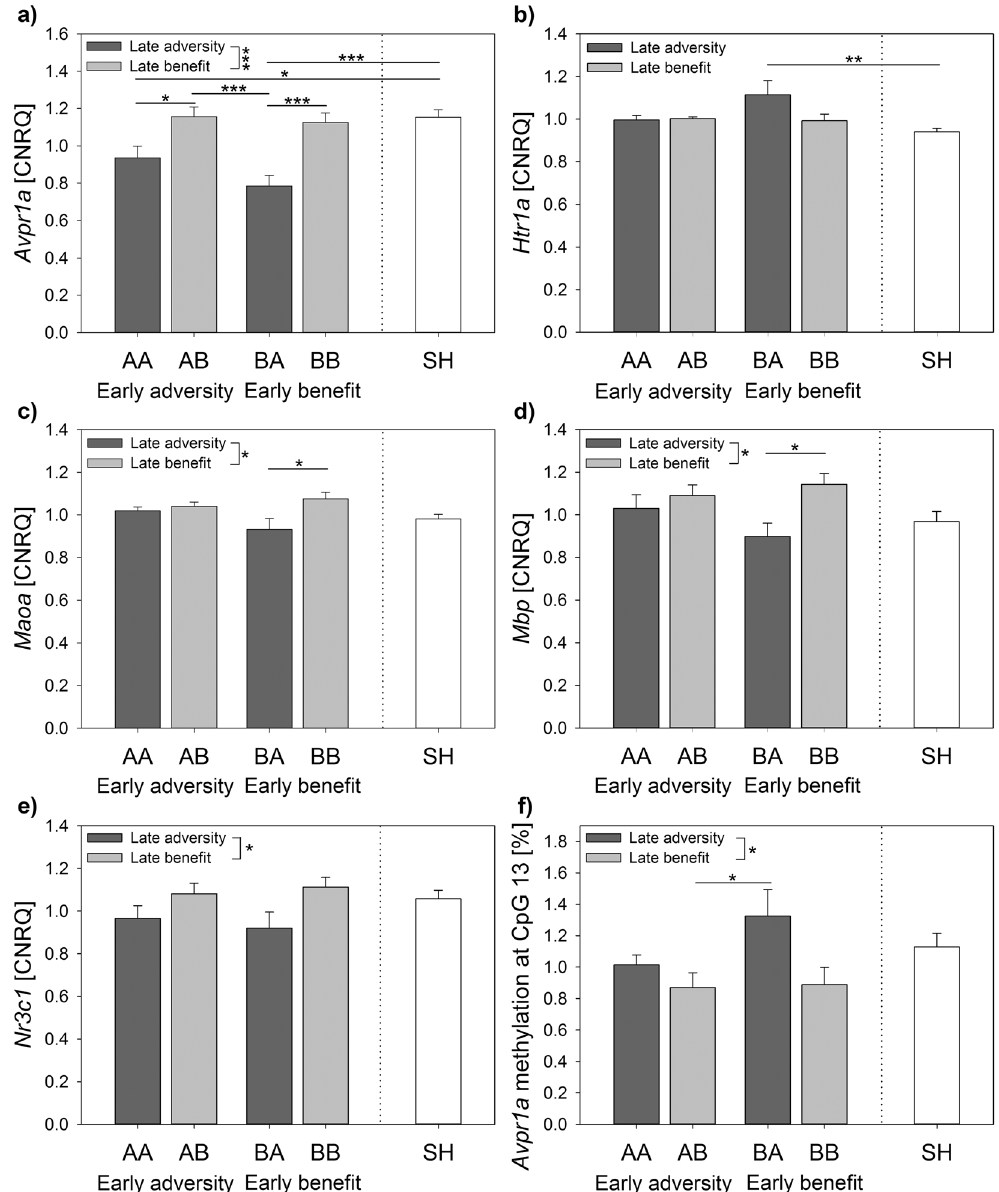
Figure 4. Gene expression and DNA methylation in the hippocampus. ( a–e ) Quantitative real-time polymerase chain reaction (qRT-PCR) analysis of ( a ) Avpr1a , ( b ) Htr1a , ( c ) Maoa , ( d ) Mbp , and ( e ) Nrc31 mRNA as well as ( f ) pyrosequencing analysis of bisulphite-treated DNA at CpG site 13 within the Avpr1a gene of mice grown up in an early adverse (AA and AB) or beneficial (BA and BB) environment and provided with later matching (AA and BB) or mismatching (AB and BA) conditions in adulthood. Sham-handled mice (SH) served as control. There were significant main effects of life history (Gene expression: Avpr1a : p < 0.001; Htr1a : p = 0.012; Maoa: p = 0.020; Mbp: p = 0.033; DNA methylation: Avpr1a CpG site 13: p = 0.028) and of the late phase (Gene expression: Avpr1a : p < 0.001; Maoa: p = 0.014; Mbp: p = 0.013; Nr3c1 : p = 0.013; DNA methylation: Avpr1a CpG site 13: p = 0.013). Data are given as means + s.e.m. Statistics: ANOVA, Bonferroni post-hoc testing. * p ≤ 0.05; ** p ≤ 0.01; *** p ≤ 0.001. n = 11–13 ( a – e ), n = 8–13 ( f ). CNRQ = Calibrated Normalized Relative